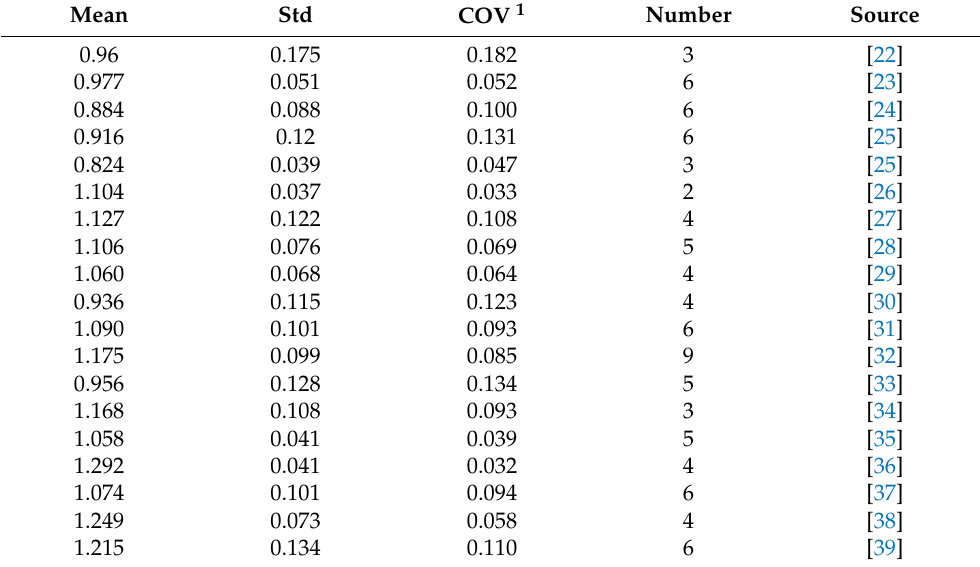
Table 1. Statistical table of the uncertainty factor K P